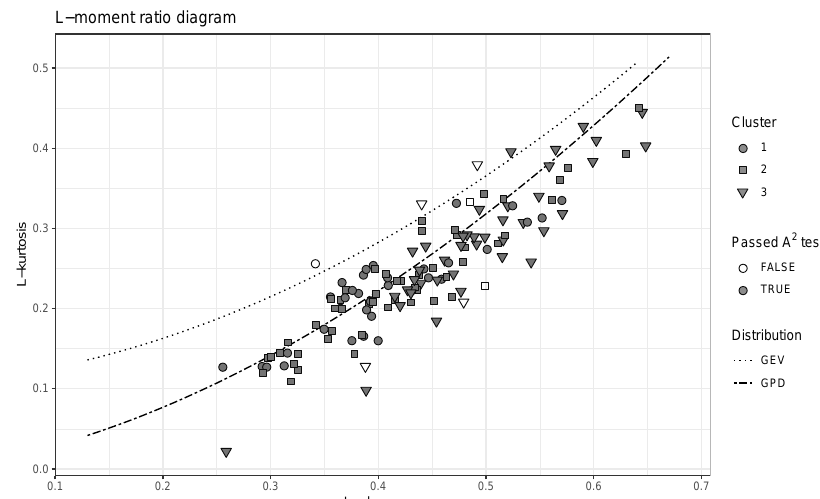
Figure 4. L-moment ratio diagram with highlighted clusters and results of at-site Anderson–Darling test. The dashed lines show the theoretical L-moment ratio for Generalized Pareto Distribution (GPD) and Generalized Extreme Value distribution (GEV) and the points the L-moment ratios for each